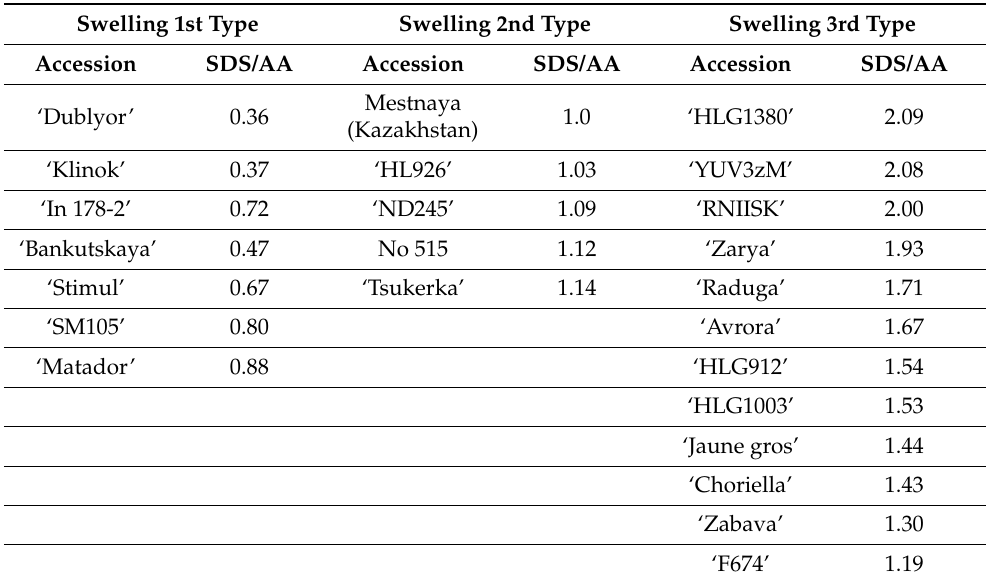
Table 4. Differentiation of maize genotypes according to the type of milled grain